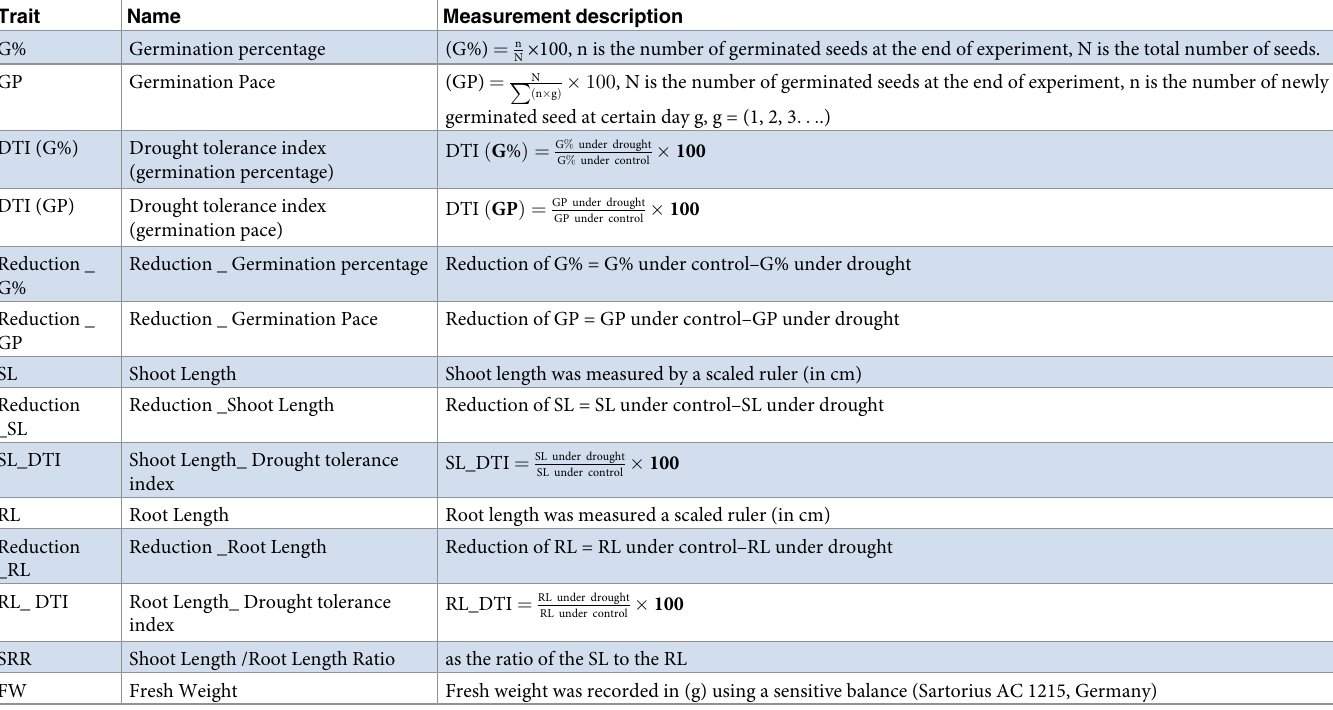
Table 1. The name and abbreviation of measured traits and respective description of